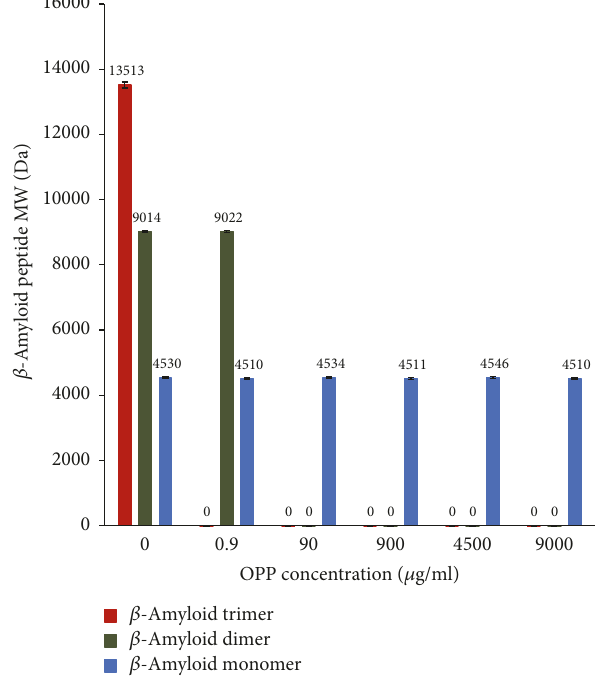
Figure 4: MALDI-TOF mass spectrometric data on A 𝛽 42 aggrega- tion pooled from 5 runs. In the absence of OPP (0 𝜇 g/ml), A 𝛽 42 dimers and trimers form. At an OPP concentration of 0.9 𝜇 g/ml, only dimers will form. At 90 𝜇 g/ml and higher, only monomers exist and no dimers nor trimers are